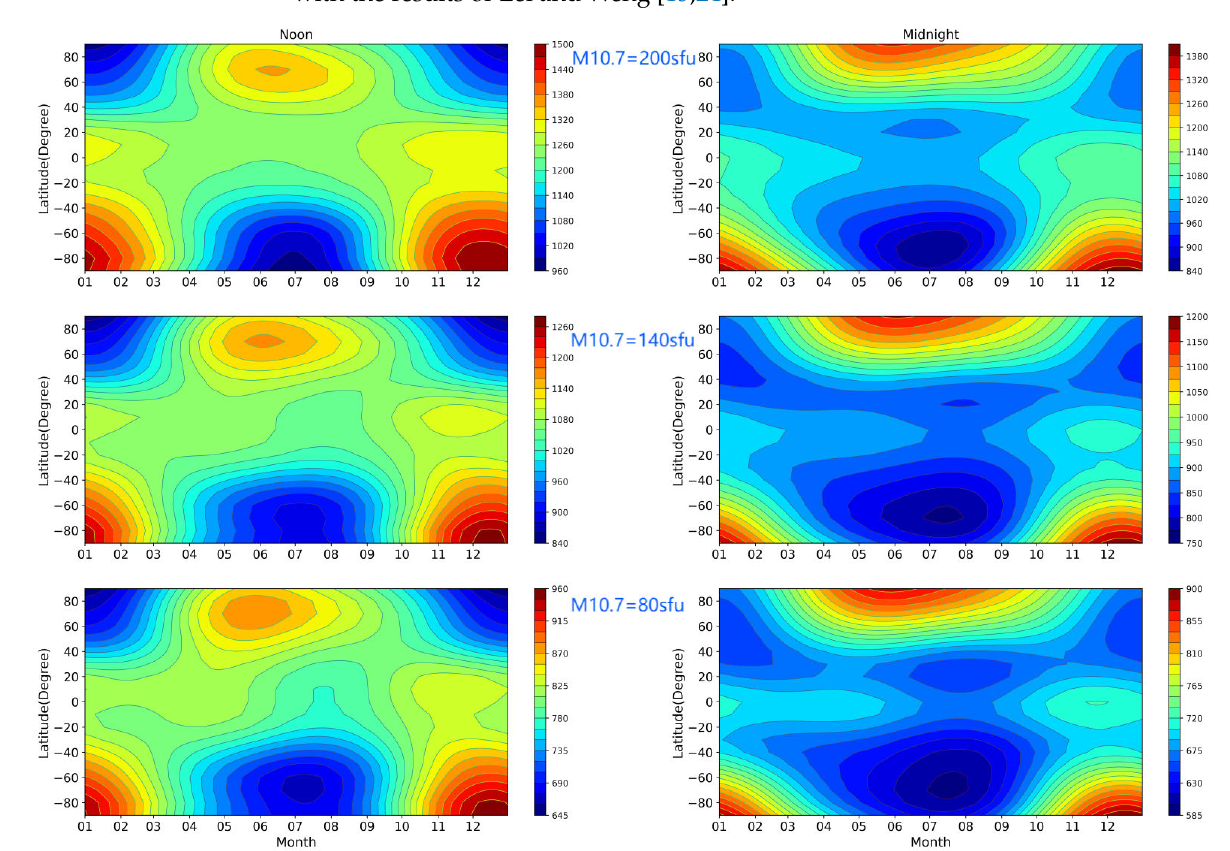
Figure 7. Seasonal variations of exospheric temperature from our ETM at noon ( left ) and midnight ( right ) under different solar activity